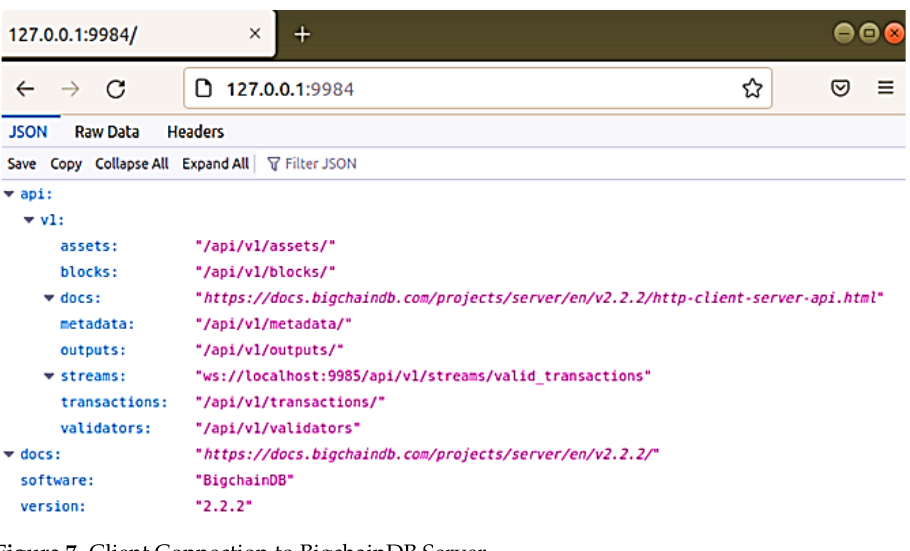
Figure 7. Client Connection to BigchainDB Server.